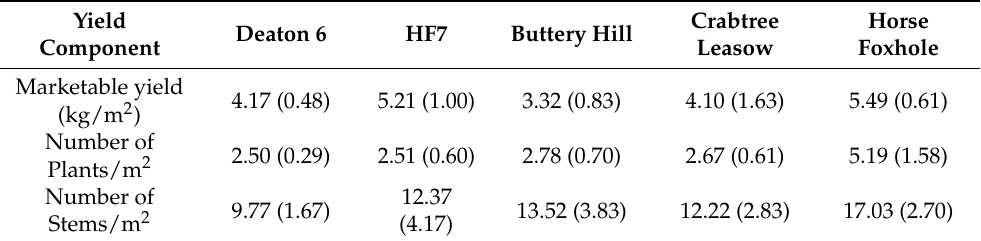
Table 5. Summary statistics (mean with standard deviation in parentheses) of the potato yield sampling results at five different study sites.